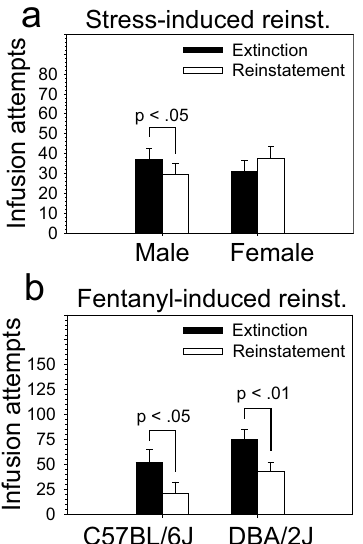
Figure 6. Stress-induced and IV fentanyl-induced reinstatement of intravenous fentanyl self-administration in C57BL/6J and DBA/2J mice. Mice were evaluated on restraint stress-induced and IV fentanyl-induced reinstatement. For both types of reinstatement, performance on a single reinstatement session was compared to an extinction session from the prior day. ( a ) Males, but not females, significantly decreased infusion attempts following acute restraint stress ( p < .05). Notably, there was a non-significant trend in females to increase infusion attempts following acute restraint stress. ANOVA did not reveal a significant effect of strain on restraint stress- induced reinstatement. ( b ) As a group, mice significantly decreased infusion attempts following non-contingent IV fentanyl infusion (280 µg/kg bolus infusion). This effect was evident in both strains and was not significantly influenced by strain or sex. Data are presented as the mean ±